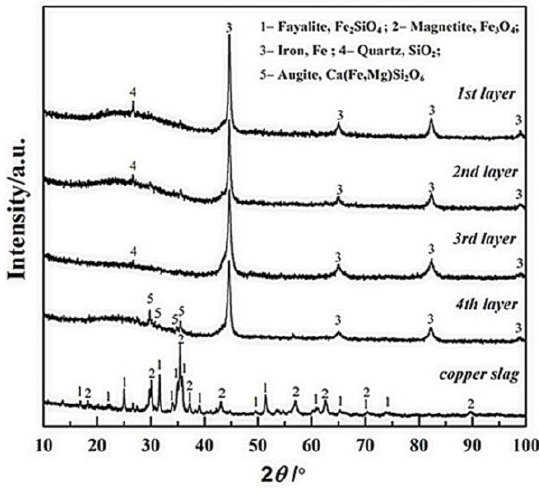
Figure 8. XRD patterns of copper slag and metallization pellets.